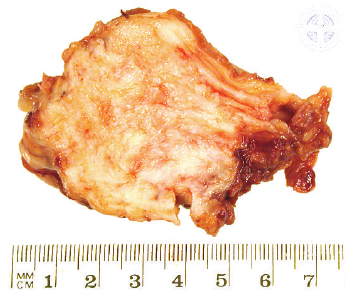
Figure 3: Macroscopic appearance of elastofibroma showing grey- ish white fibrous areas admixed with adipose tissue.